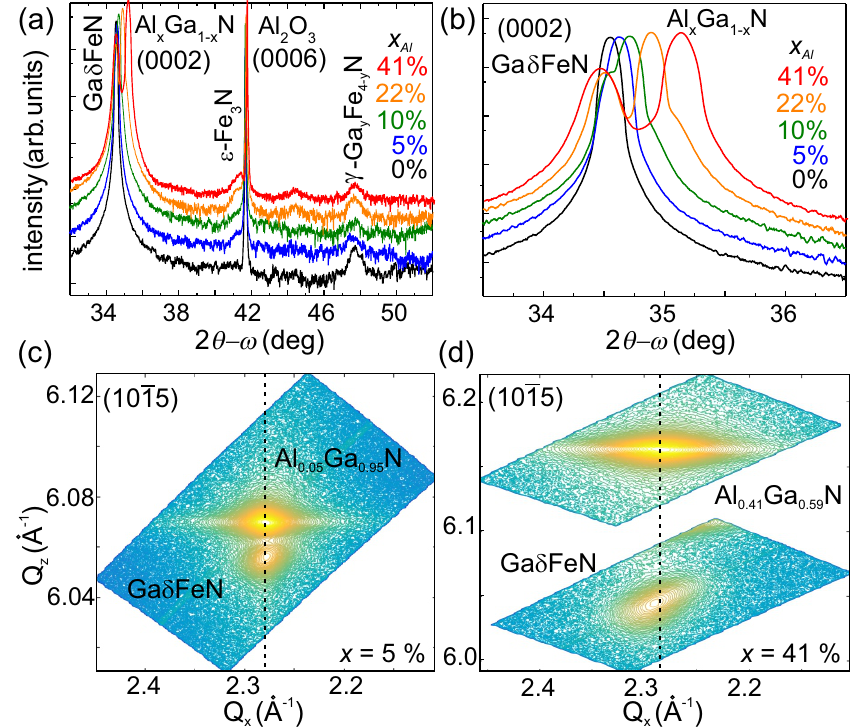
Figure 2. ( a ) Radial 2 θ - ω scans collected along the [ 0001 ] growth direction with the diffraction peaks identified for the Al x Ga 1 − x N buffer, the Ga δ FeN layers and the embedded nanocrystal phases[28,29]. ( b ) Close-up of the (0002) diffraction peaks of the Al x Ga 1 − x N buffer and of the Ga δ FeN layers. ( c , d ) Reciprocal space maps of the ( 10¯15 ) diffraction plane for the samples containing 5% and 41% Al in the buffer,